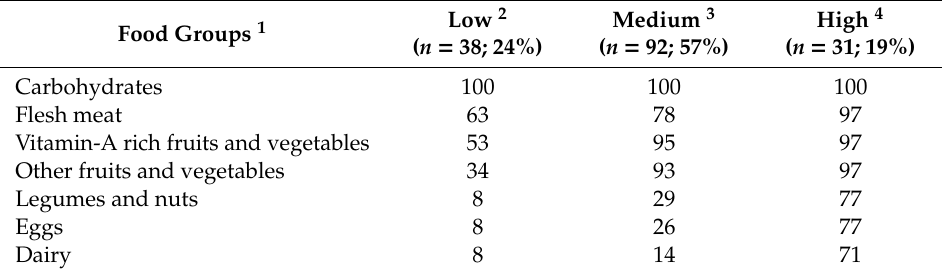
Table 3. Percent of food groups consumed by households by dietary diversity tertile ( n =